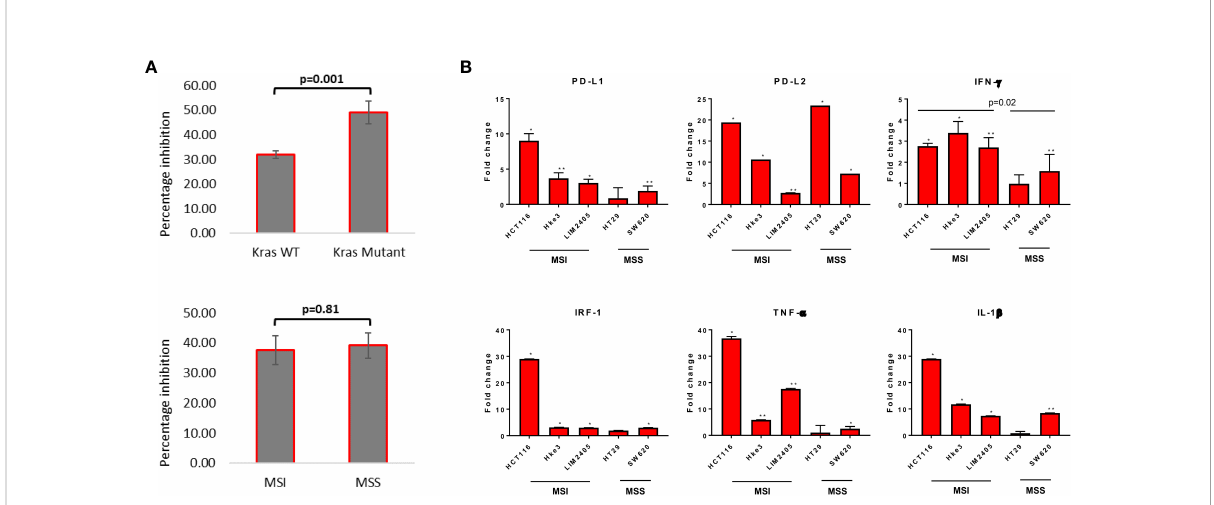
FIGURE 1 Measurement of cytotoxicity and expression of major immune response genes upon reovirus treatment. (A) MTT assay revealed that reovirus (pelareorep) treatment of 5 MOI for 24 hrs induced signi fi cant growth arrest in all 13 CRC cell lines studied. Mutational status of KRAS was more relevant (p=0.001) than inherent MMR status of cell lines (p=0.81). (B) While transcriptional level expression of immune response regulators such as PD-L1, PD-L2, IFN- g , IRF-1, TNF- a and IL-1 b overall increased, no signi fi cant difference between KRAS Mut and KRAS Wt cell lines observed. MSI cell lines expressed signi fi cantly higher levels of IFN- g compared to MSS cell lines upon reovirus infection. Most of the alterations were not prominent in HT29 except for PD-L2. Fold difference of 1 indicates no expressional level changes. * p ≤ 0.05, compared to the untreated control group; ** p ≤ 0.01 compared to the untreated control